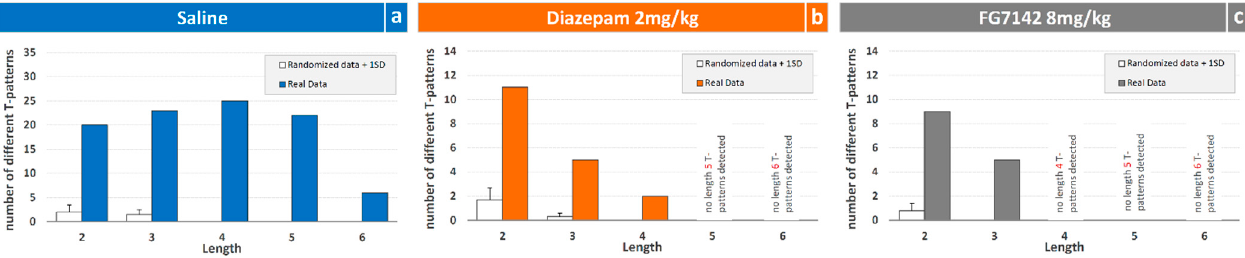
Figure 5. Overall number of different T-patterns ( y -axis) detected based on their different length ( x -axis) in rats injected with saline ( a ), diazepam 2 mg/kg ( b ) and FG7142 8 mg/kg ( c ). Filled bars = number of T-patterns detected in real data; white/empty bars = numbers of patterns +1SD detected in randomized data. Data obtained from the analysis of three groups each encompassing 10 subjects. See Figure 1 for abbreviations.